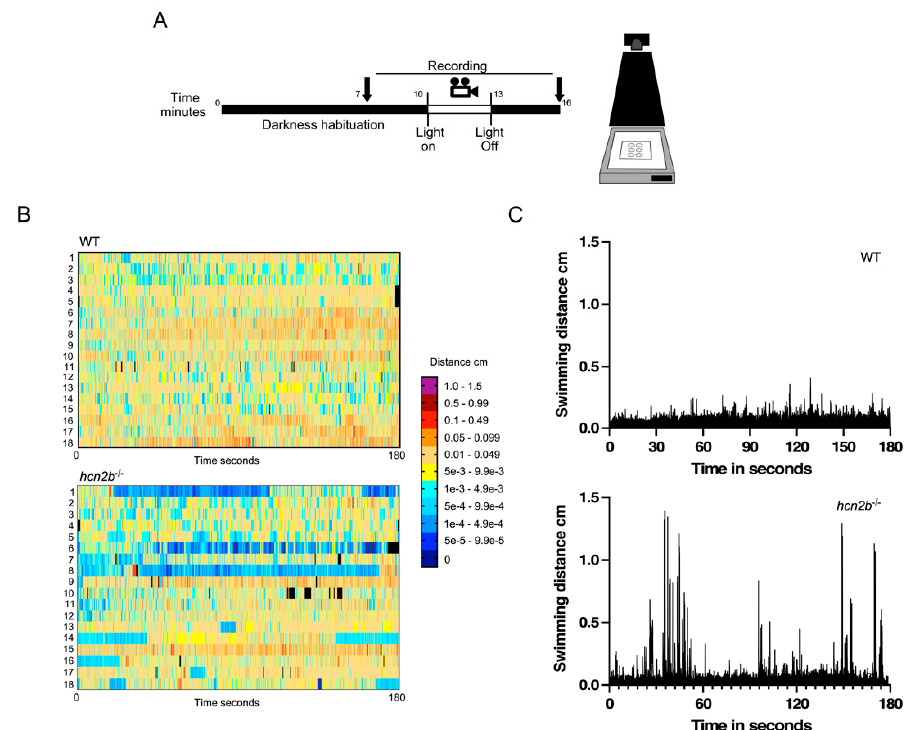
Figure 4. Motility during dark-light-dark transitions. ( A ) Video recording protocol. At seven days post-fertilization, larvae were placed in 23 mm diameter wells and covered from light for ten minutes for habituation to darkness, then exposed to three minutes of continuous light and, finally, three minutes of darkness. ( B ) Heatmap of the swimming behavior of WT and hcn2b − / − . 18 WT and 18 hcn2b mutants are shown. Low activity periods that last over time (in blue) can be interpreted as absence periods (larvae 1, 6 and 8). The high activity in red and purple are fast in a short period in time (see hcn2b − / − (larvae 1, 8, 15 and 18). ( C ) Swimming distances of 18 WT and 18 hcn2b − / − mutants in the light period. The hcn2b − / − mutants displayed brief peaks as indication of fast hyperactivity episodes.